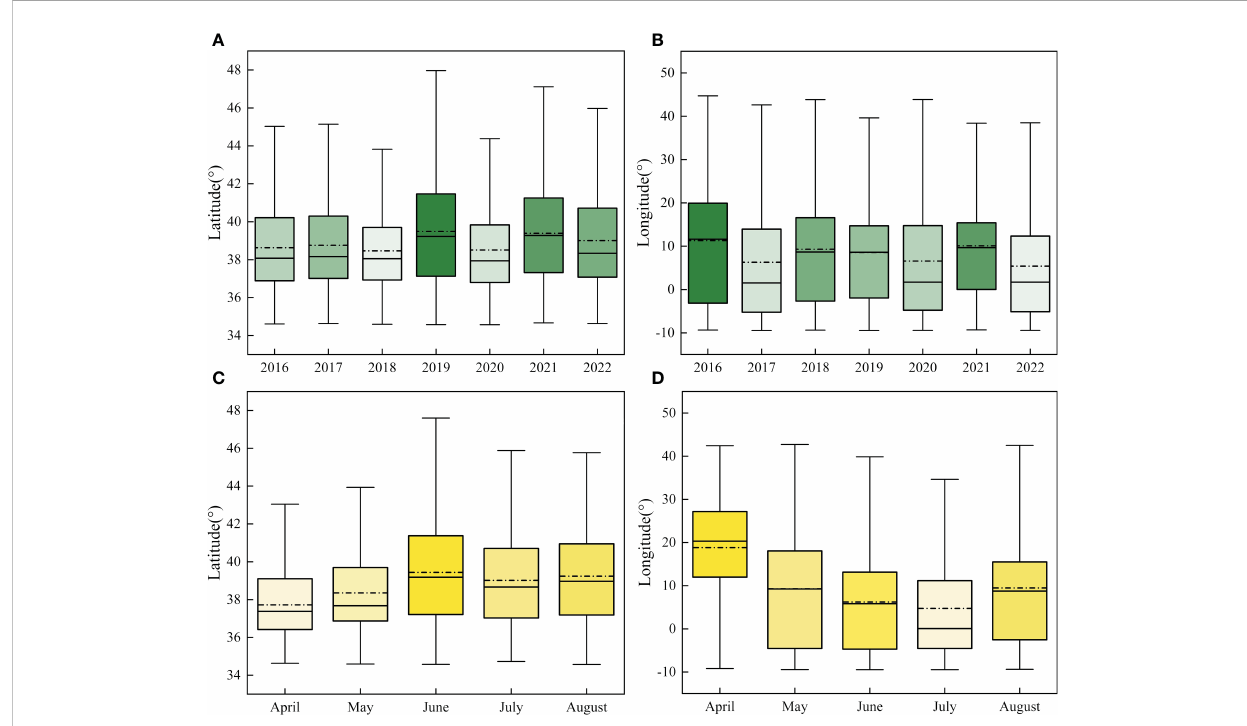
FIGURE 5 The boxplot of effective landing points distribution; (A) Latitude distribution in different years; (B) Longitude distribution in different years; (C) Latitude distribution in different months; (D) Longitude distribution in different